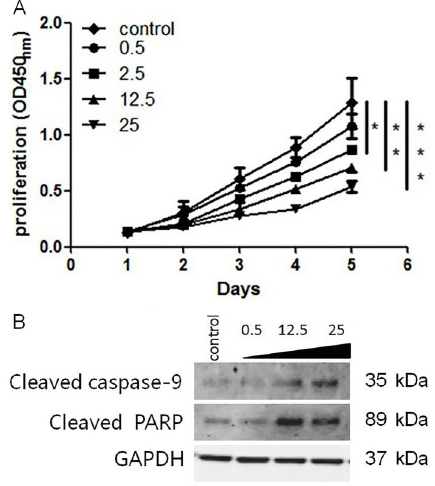
Figure 1. Ethanol extracts of Antrodia cinnamomea (EEA) inhibited cell proliferation in a dose-dependent manner. A , SAS cells were treated with EEA ranging from 0.5 to 25 m g/m, and proliferation inhibition was signi fi cantly observed in cells treated with EEA over 2.5 m g/mL after incubation for 5 days. B , Cleaved caspase-9 and cleaved PARP were increased in cells treated with